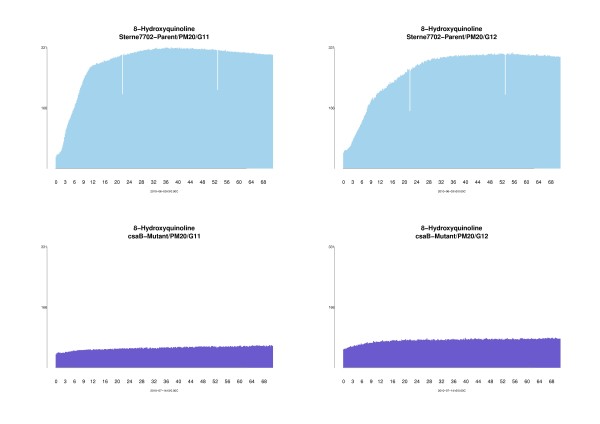
Bar plots for 8-Hydroxyquinoline. The bar plots indicate a decrease in cell growth for the AP50c mutant as compared to the wild type AP50c strain over a course of 72 hours. The top light blue bar plots represent 8-Hydroxyquinoline growth profiles located in PM20/G11 (left) and PM20/G12 (right) for the mutant strain. The bottom dark blue bar plots represent 8-Hydroxyquinoline growth profiles located in PM20/G11 (left) and PM20/G12 (right) for the parent strain.